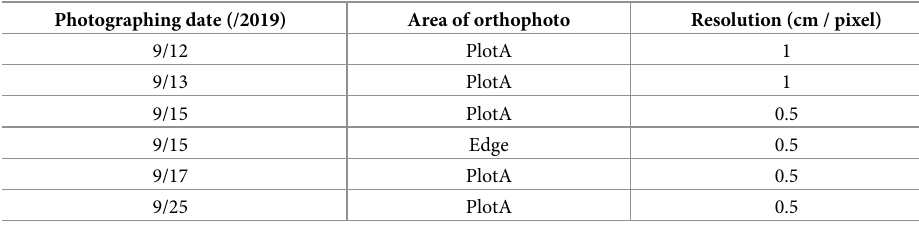
Table 1. Training data set for Model_1.